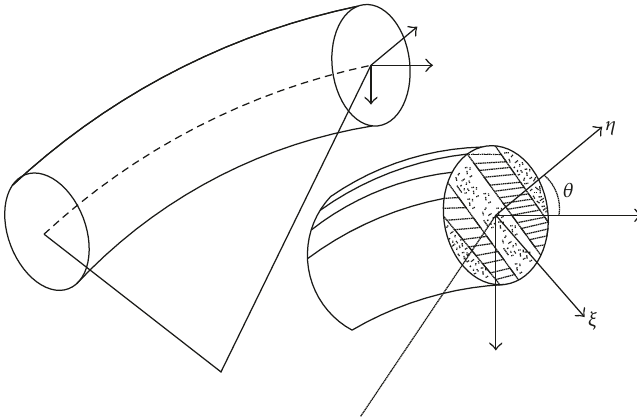
Figure 1: Geometry of a naturally curved and twisted anisotropic